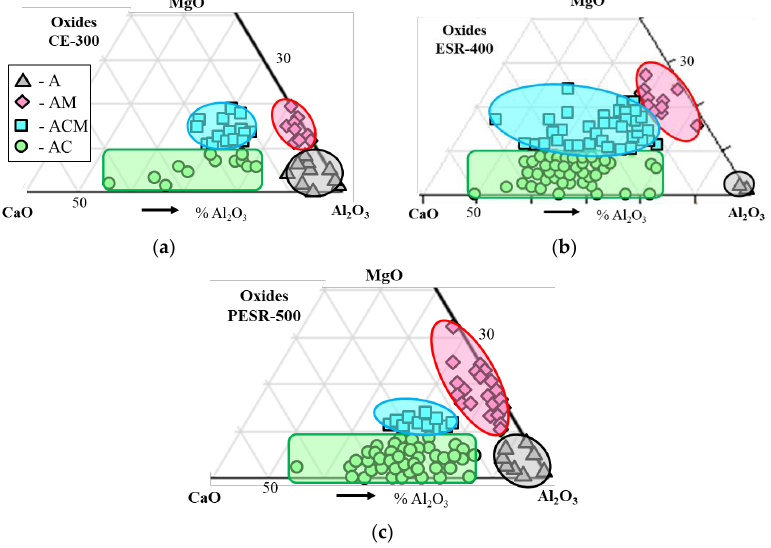
Figure 4. Compositions of oxide inclusions in different samples observed by two-dimensional (2-D) investigations on polished sample surfaces, ( a ) CE-300 M ( b ) ESR-400, and ( c ) PESR-500.